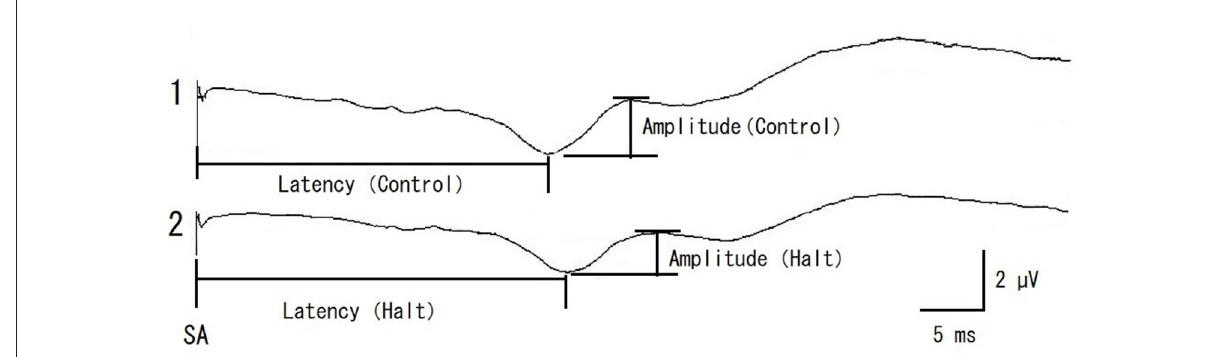
FIGURE2 Representative recording of control SEP (pre-operative control, 1) and multifidus muscles retracting (Halt, 2) in a case of 11 years old male miniature dachshund enrolled in this study. The SEP amplitude was determined as the peak-to-peak amplitude of initial positive and next negative waves. The SEP latency was determined from the stimulation artifact (SA) to the peak of initial positive wave. The amplitude rate and latency rate were calculated as follows; The amplitude rate = the amplitude (Halt)/the amplitude (pre-operative control) × 100, The latency rate = the latency (Halt)/the latency (pre-operative control) × 100, respectively.